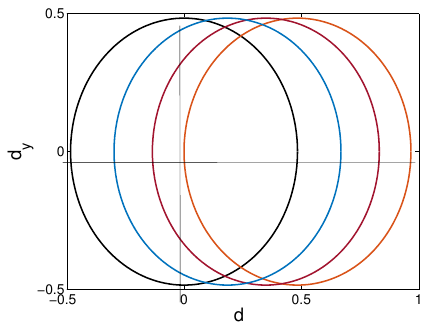
Figure 10. In the pure SSH model (transmission coefficients independent of k ), the paths the Hamiltonian takes in momentum space are circular. Varying phases φ a and φ b causes the path traced out by (cid:126) d to shift horizontally and change radius, leading to transitions between winding numbers 0 and 1. The right-most path here has winding number 0, while the others shown have winding number 1. If the transmission amplitudes are k -dependent, the curves are no longer circular, but similar transitions between ν = 0 and ν = 1 still occur as the phases are